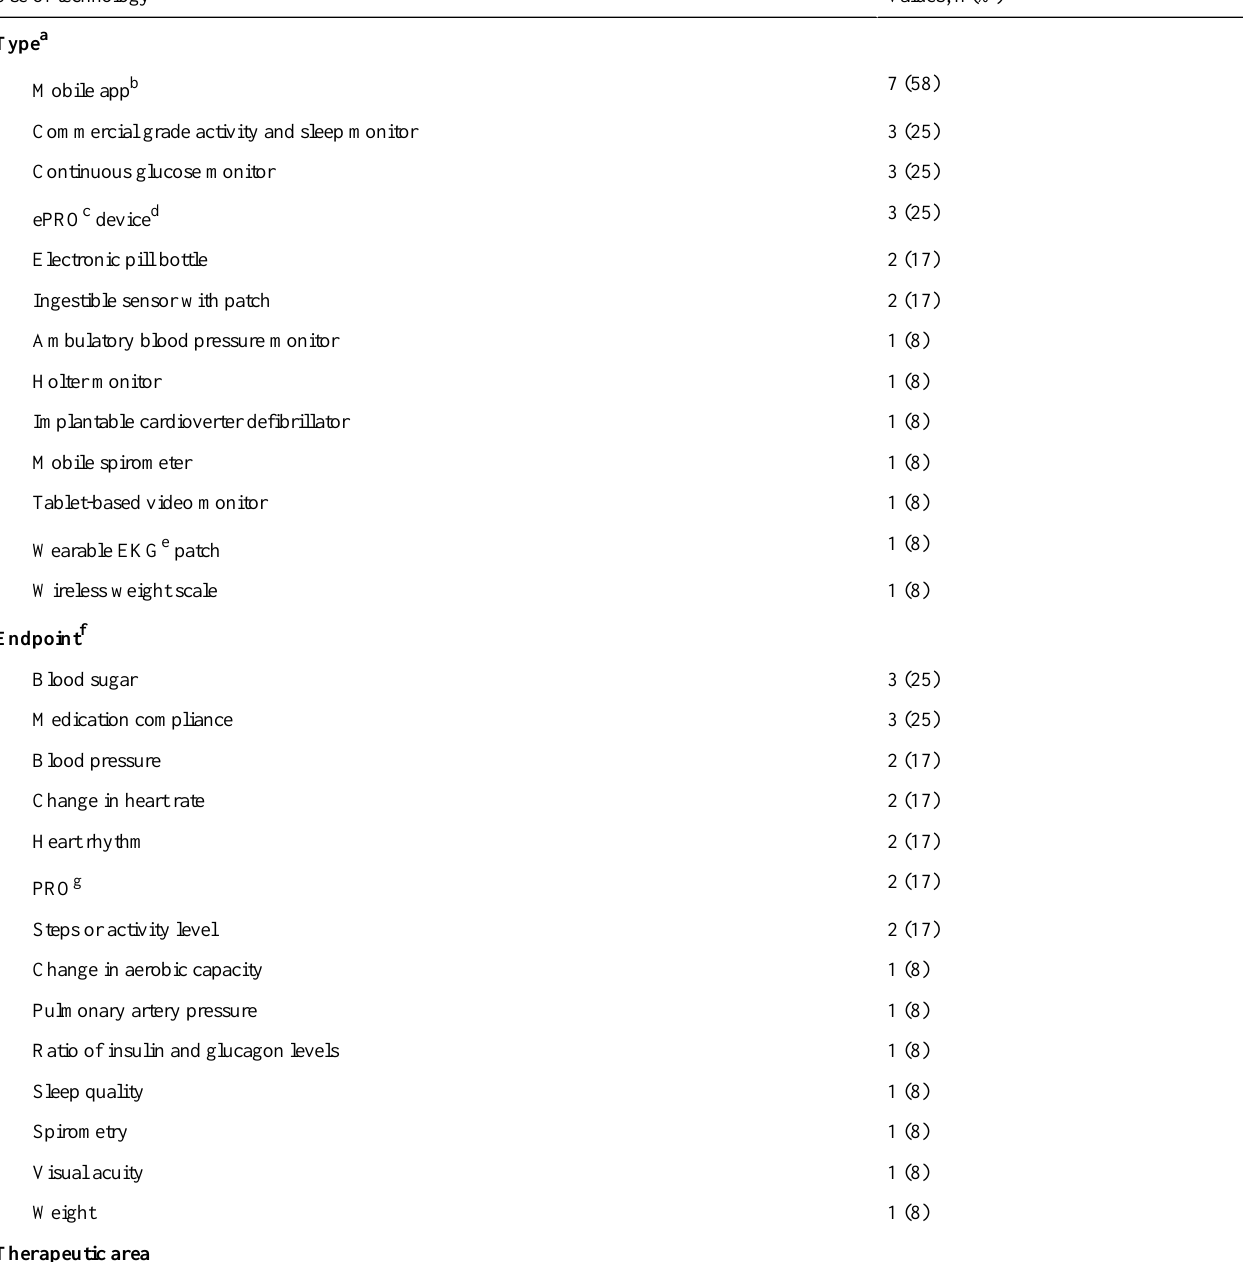
Values, n (%)Use of